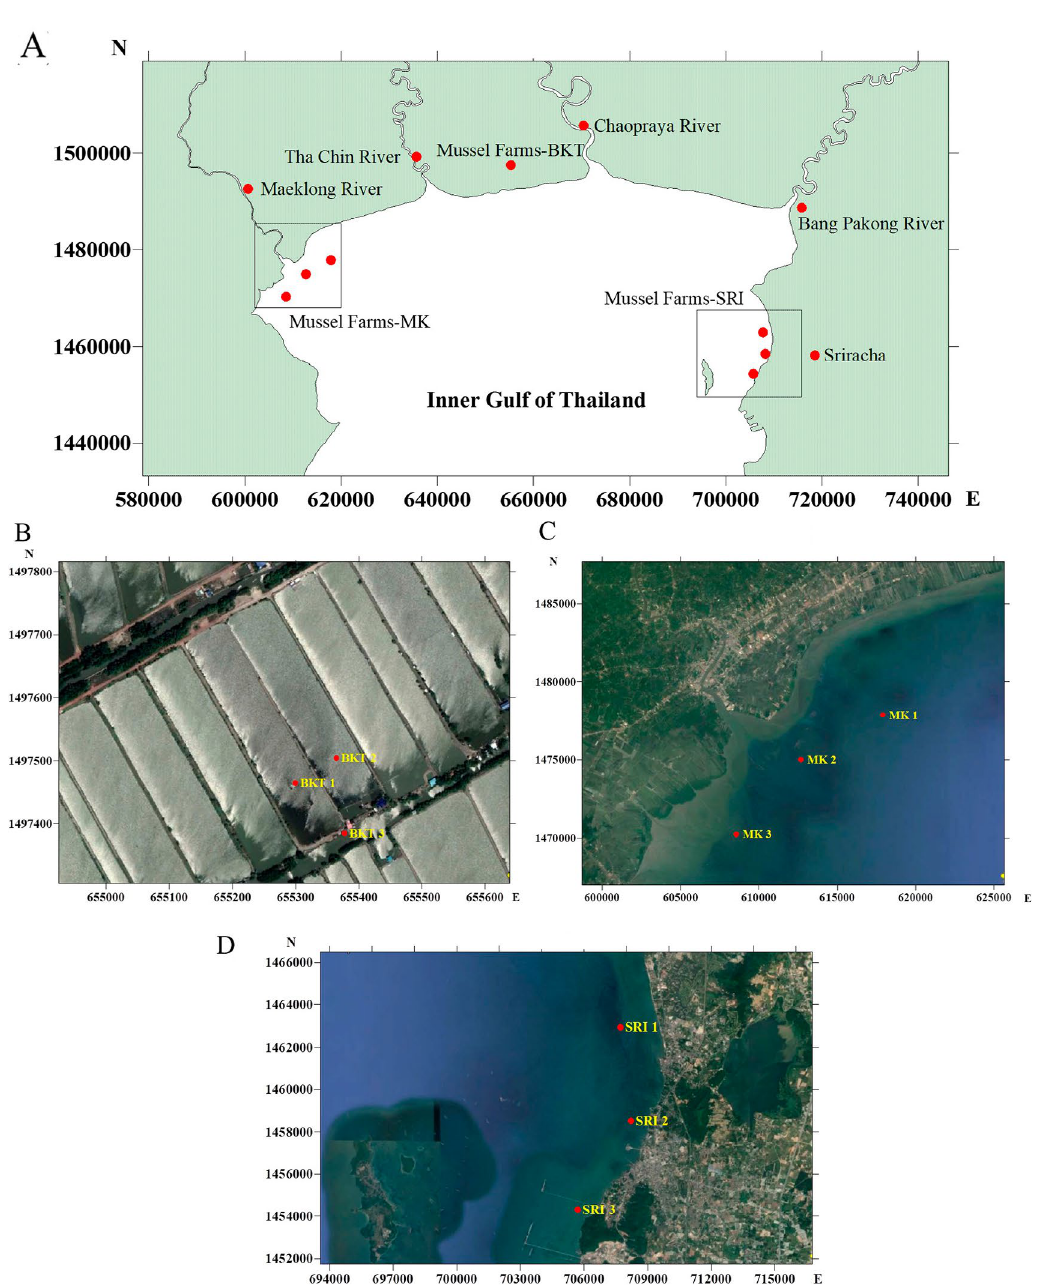
Fig. 1. – Study area: A, inner Gulf of Thailand and location map showing sampling stations for each green mussel farm; B, Bang Khun Tien (BKT); C, Maeklong river mouth (MK); and D, Sriracha (SRI). Panels B, C and D represent the pond, estuary and coastal areas,